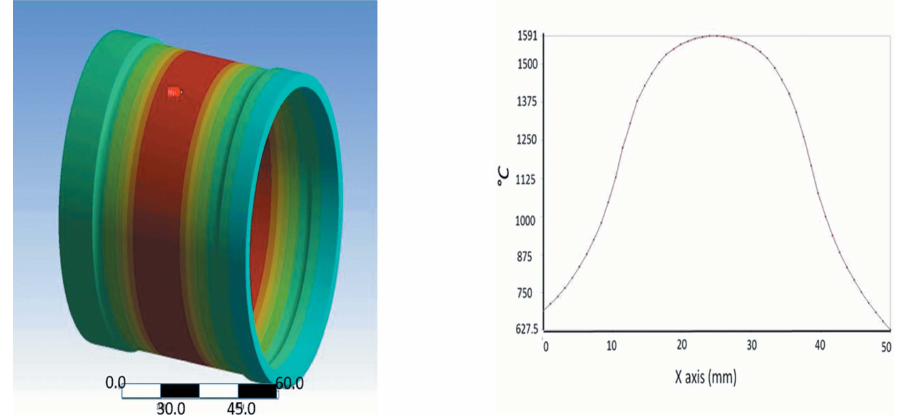
Figure 1 Temperature distribution on the rotating filter by finite-element